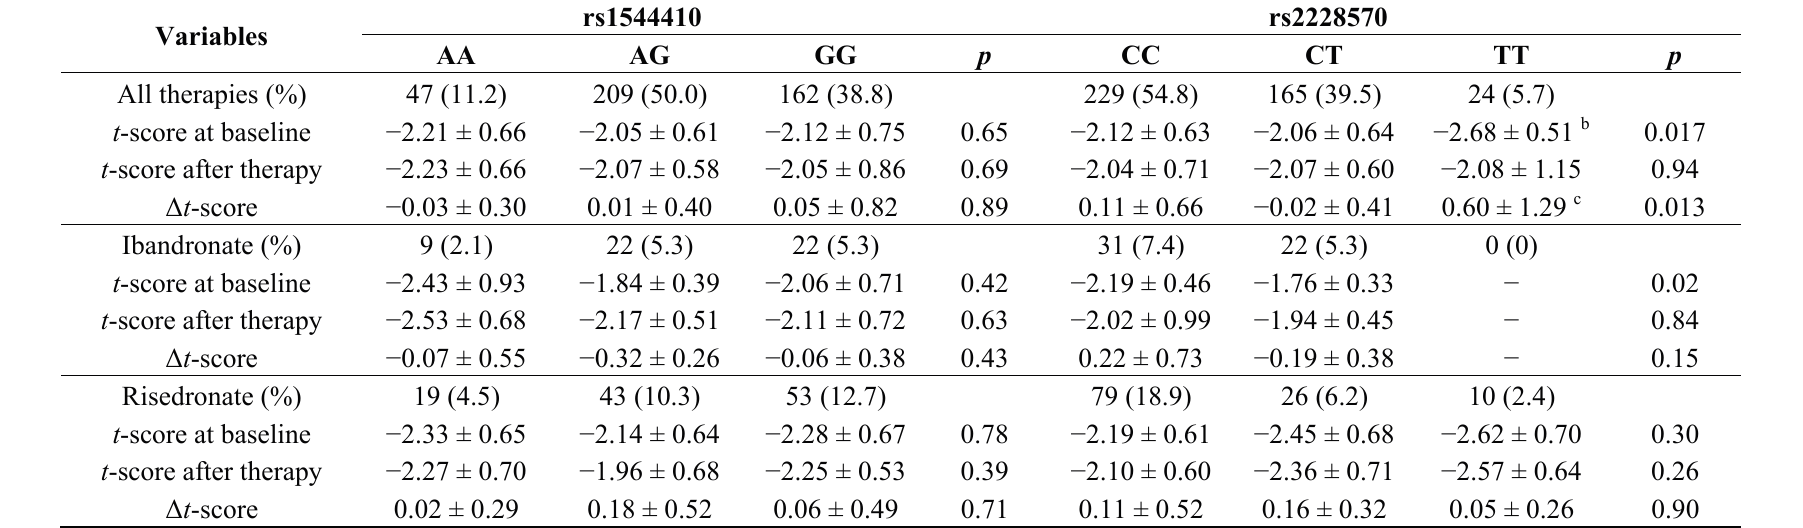
Table 4. Therapies according to rs1544410 and rs2228570